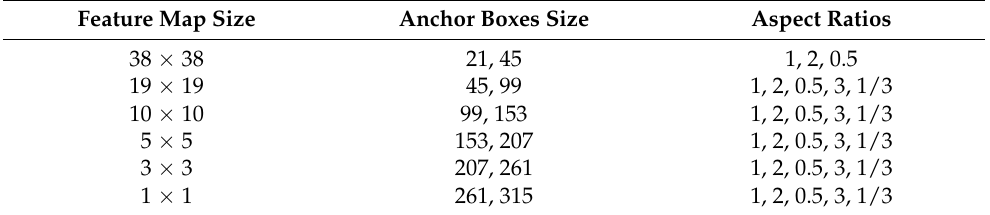
Table 1. Predefined anchors and aspect